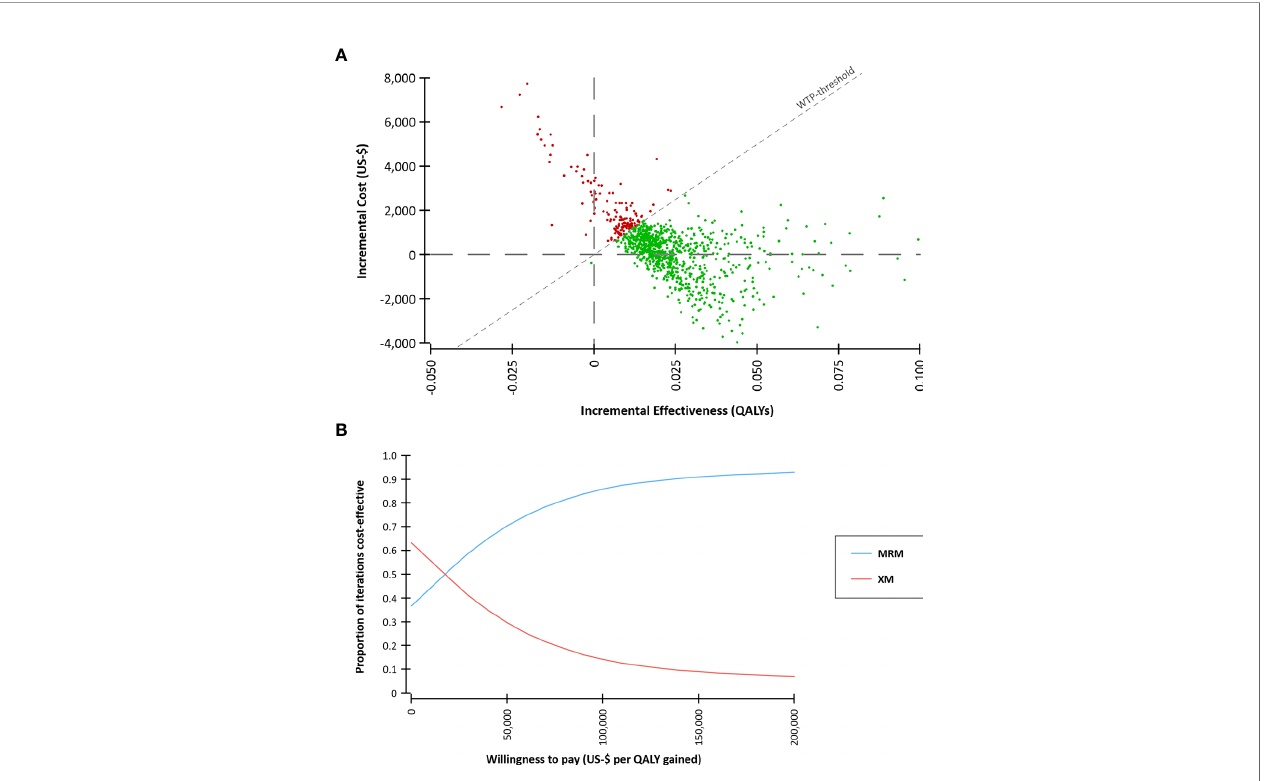
FIGURE 4 | Probabilistic sensitivity analysis based on 30,000 Monte Carlo simulations. (A) Incremental costs and effects comparing MR-mammography (MRM) versus x-ray mammography (XM). A willingness-to-pay (WTP) threshold of $ 100,000 per quality-adjusted life year (QALY) gained was assumed. (B) Cost- effectiveness acceptability curve. At a WTP of $ 100,000 per QALY gained, 86% of the iterations were cost-effective.